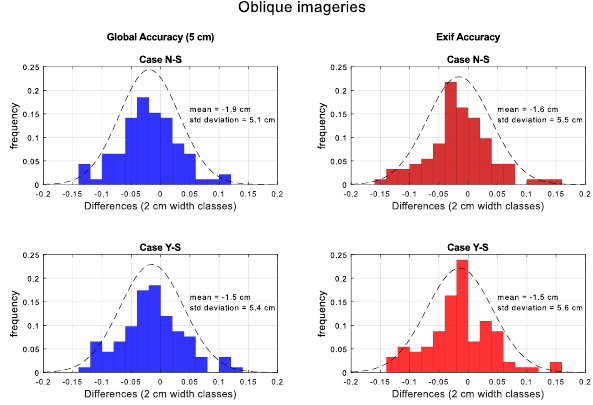
Figure 8. Distribution of the discrepancies computed on the validation points for the oblique imagery